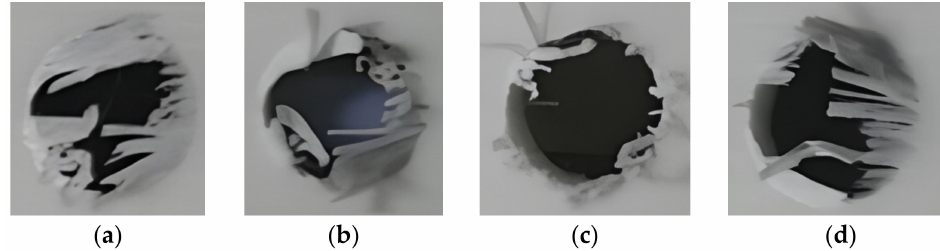
Figure 4. Morphology of milling holes: ( a ) Single-edge milling cutter; ( b ) Double-edge milling cutter; ( c ) Corn milling cutter; ( d ) PCB alloy